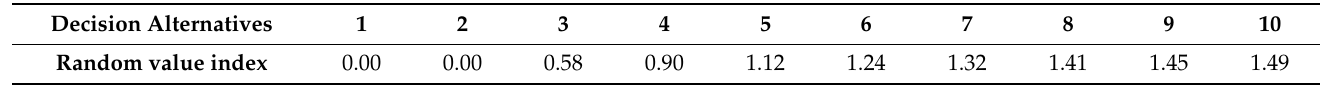
Table 6. Values of random index.